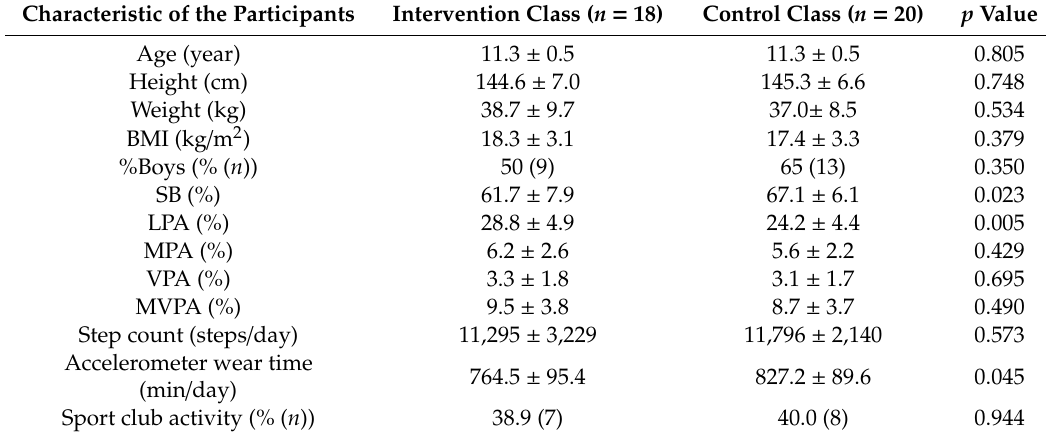
Table 3. Characteristic of the participants at